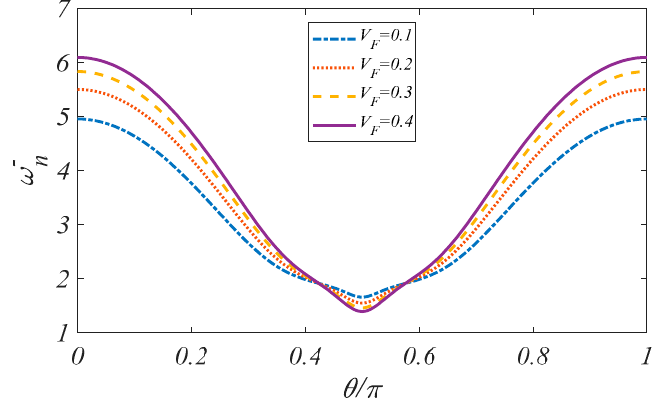
Figure 9. The e ff ect of various volume fractions of carbon fiber on the nondimensional natural frequency of MHCAP with clamp-clamp boundary conditions for di ff erent orientation angle of carbon fibers and b / a = 4, h / b = 0.1, sinusoidal temperature rise (STR), T i = 273 [K], T o = 300 [K], W CNT = 0.02, FG-A, β = 1, K p = 10 [MN / m], and K w = 100 [MN / m 3 ].